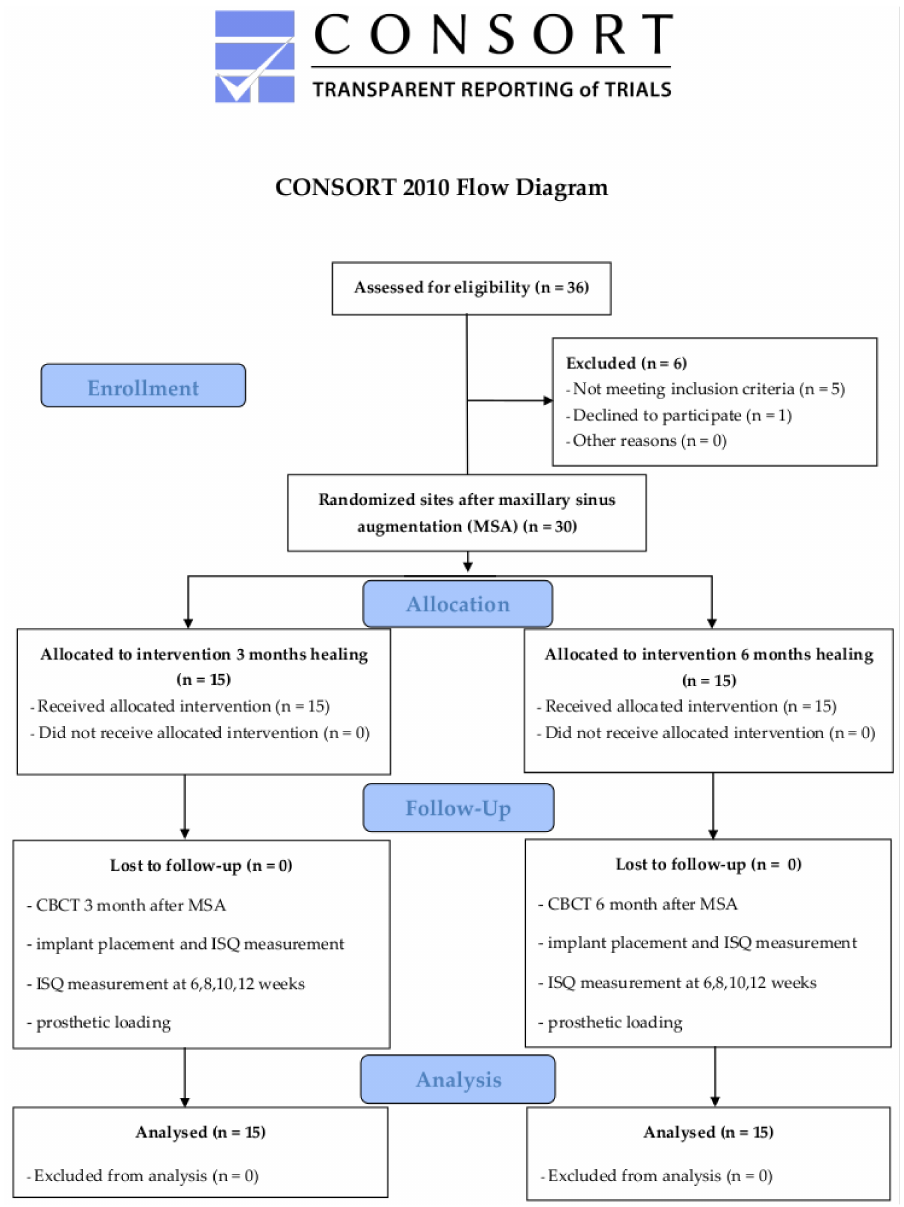
Figure 3. CONSORT flow